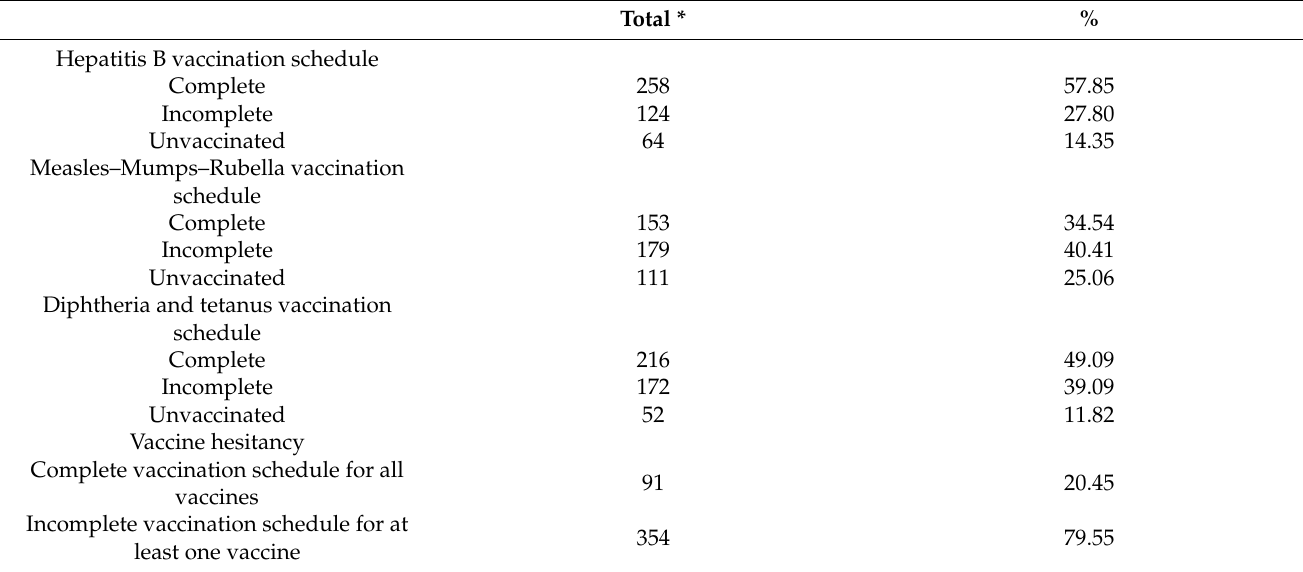
Table 3. Frequency of vaccination against hepatitis B, measles, mumps, and rubella, and diphtheria and tetanus among health workers in Bahia, Brazil, in